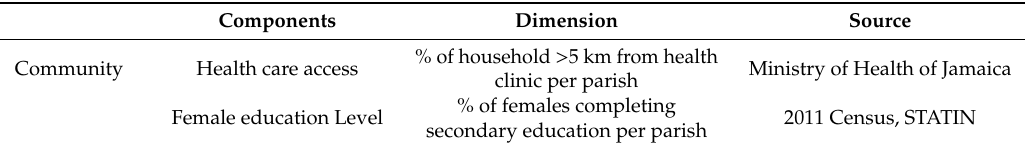
Table 3. Adaptive